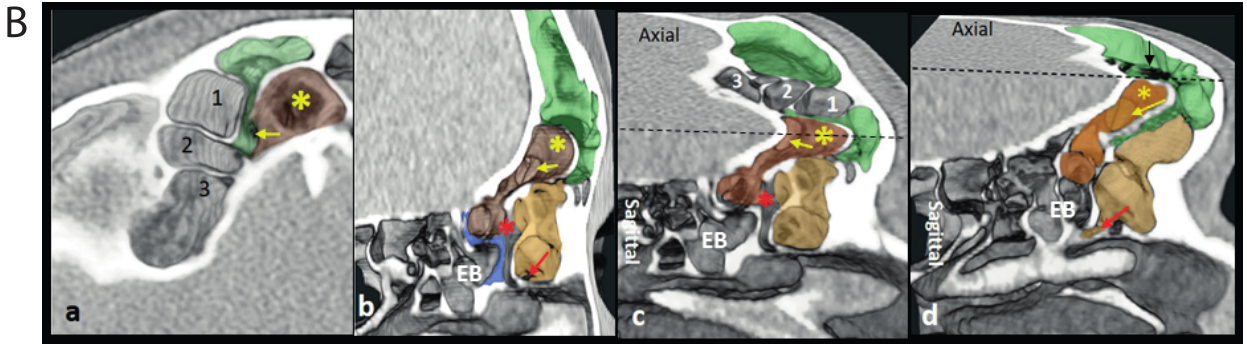
Figure 5. B. Supra Bullar Recess Space and Frontoethmoidal space expand into Frontal Sinus. a.-d. 3D axial image Fig. a., 3D sagittal image Fig. b., and 3D obliqued images (left side) (Figs. c.-d.), reveal a fronto-bullar space (brown outline/yellow asterisk) expanding into the frontal sinus. The fronto-bullar space originates from the supra-bullar space, and noted to “balloon” anteriorly within the frontal sinus, similar to a “Frontal Bulla” space (Fig. 4). A second commonality with the “Frontal Bulla” is its lateral opening which communicates with the frontal sinus (yellow arrow). The fronto-bullar space communicates directly with the middle meatus, as does the supero-posterior compartment of the IS-EUP (red asterisk). The inferior IS-EUP communicates directly with the TI (red arrow). Note that the supra-orbital frontal spaces (1,2,3) (black arrow), communicate with the EB